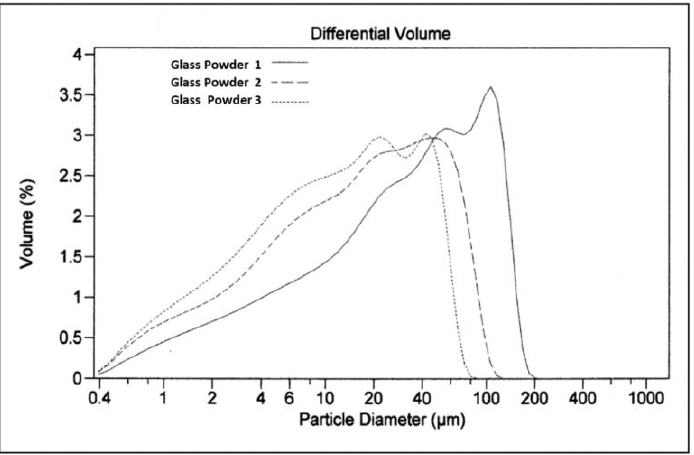
Figure 2. Differential particle size distribution of the 3 batches of glass powder [32].